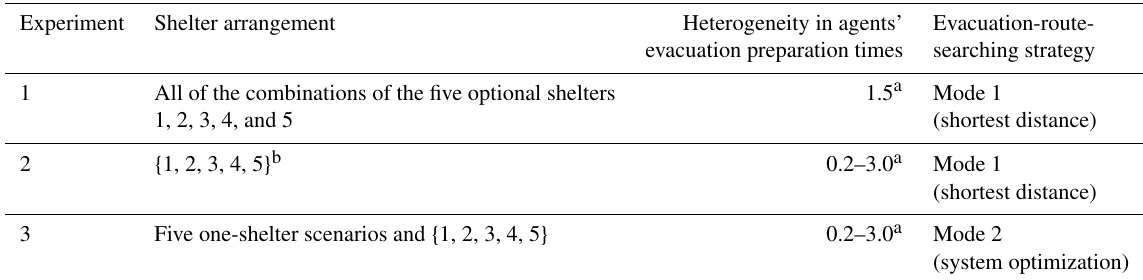
Table 2. Scenario design for simulating household evacuation processes.